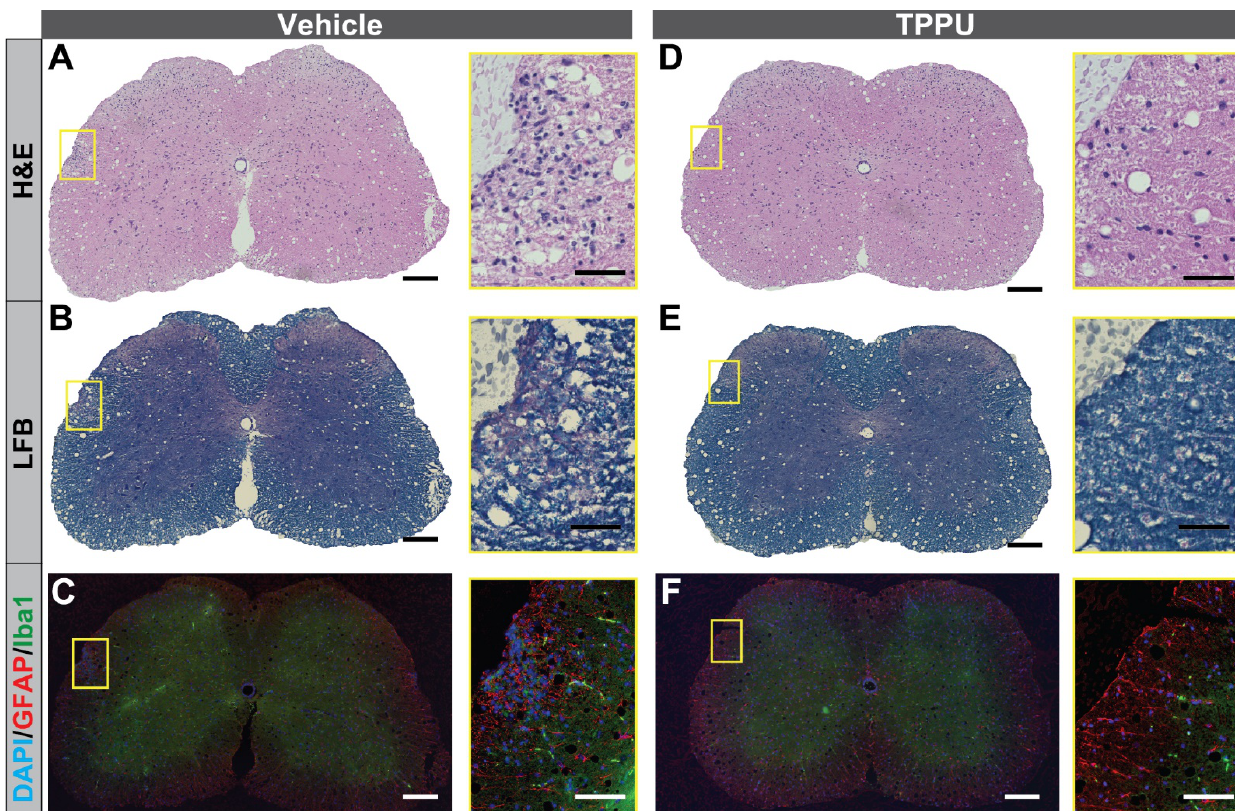
Figure 2. Histological assessment of EAE spinal cords. Representative SC sections of vehicle-treated EAE mice ( A–C ) and TPPU-treated mice ( D–F ) are shown. ( A , D ) H&E staining. ( B , E ) LFB-cresyl violet staining. ( C , F ) IHC for GFAP and Iba-1. Scale bars = 200 µm. Regions of interest are magnified (Scale bars = 50 µm).